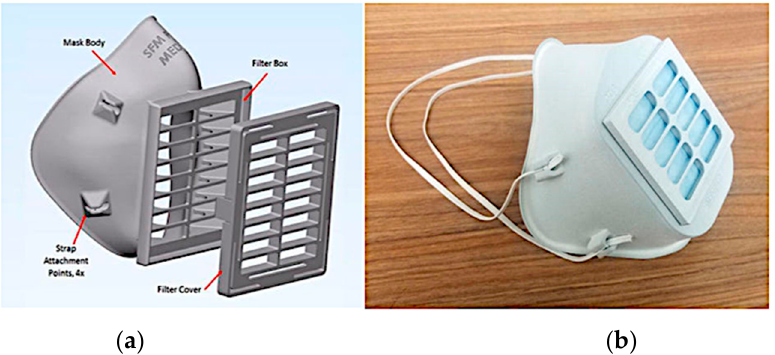
Figure 4. SLA-printed 3D Systems Stopgap facemask: ( a ) CAD representation; ( b ) printed facemask [48].